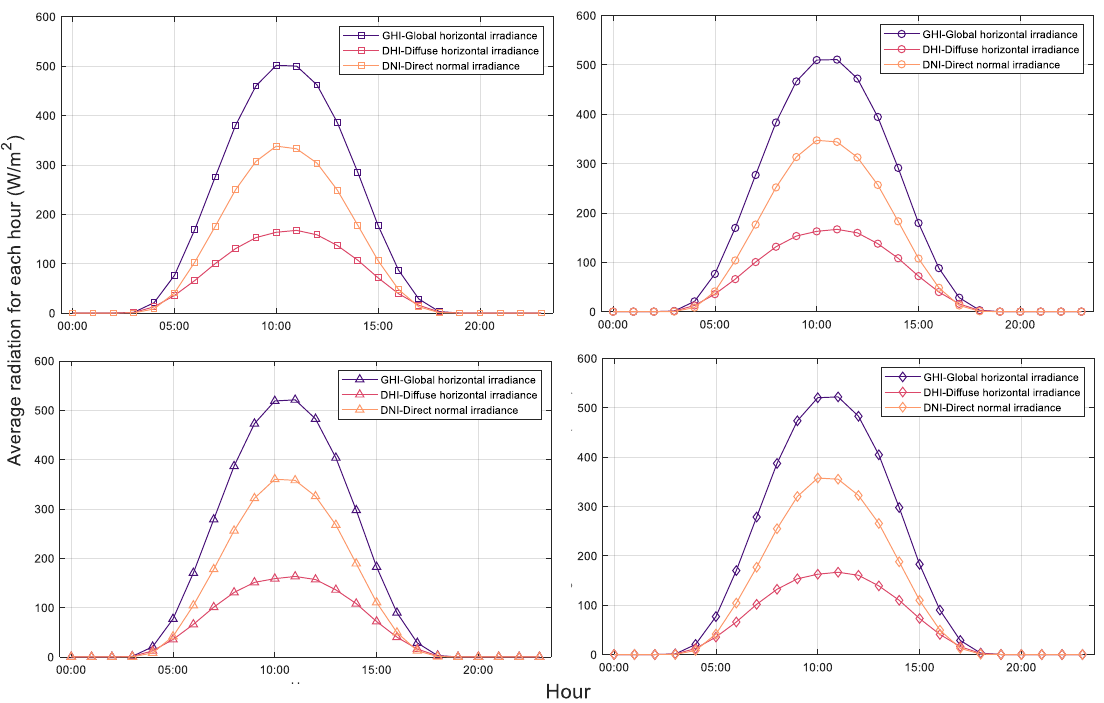
Figure 2. The curve of GHI, DHI, and DNI. The square symbol is for Lake Razim; the circle symbol is for Lake Golovita; the triangle symbol is for Lake SInoe; and the diamond symbol is for the Black Sea.